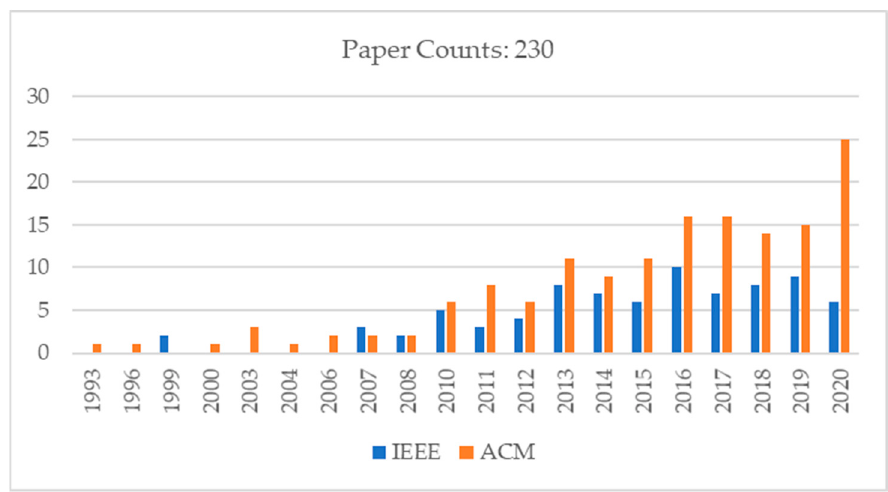
Figure 2. Distribution of publications for the subject “remote collaboration” during 1993–2020.